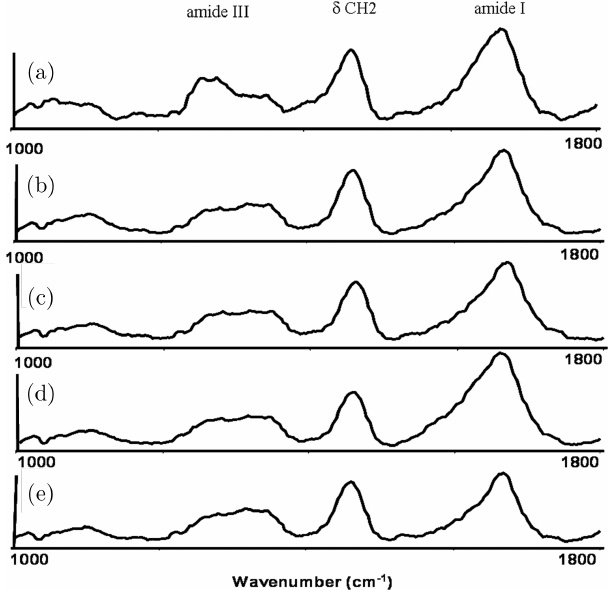
Fig. 2. Mean Raman spectra of: (a) normal, (b) tumor, (c) complete responder specimens, (d) partial responder, and (e) nonresponder.